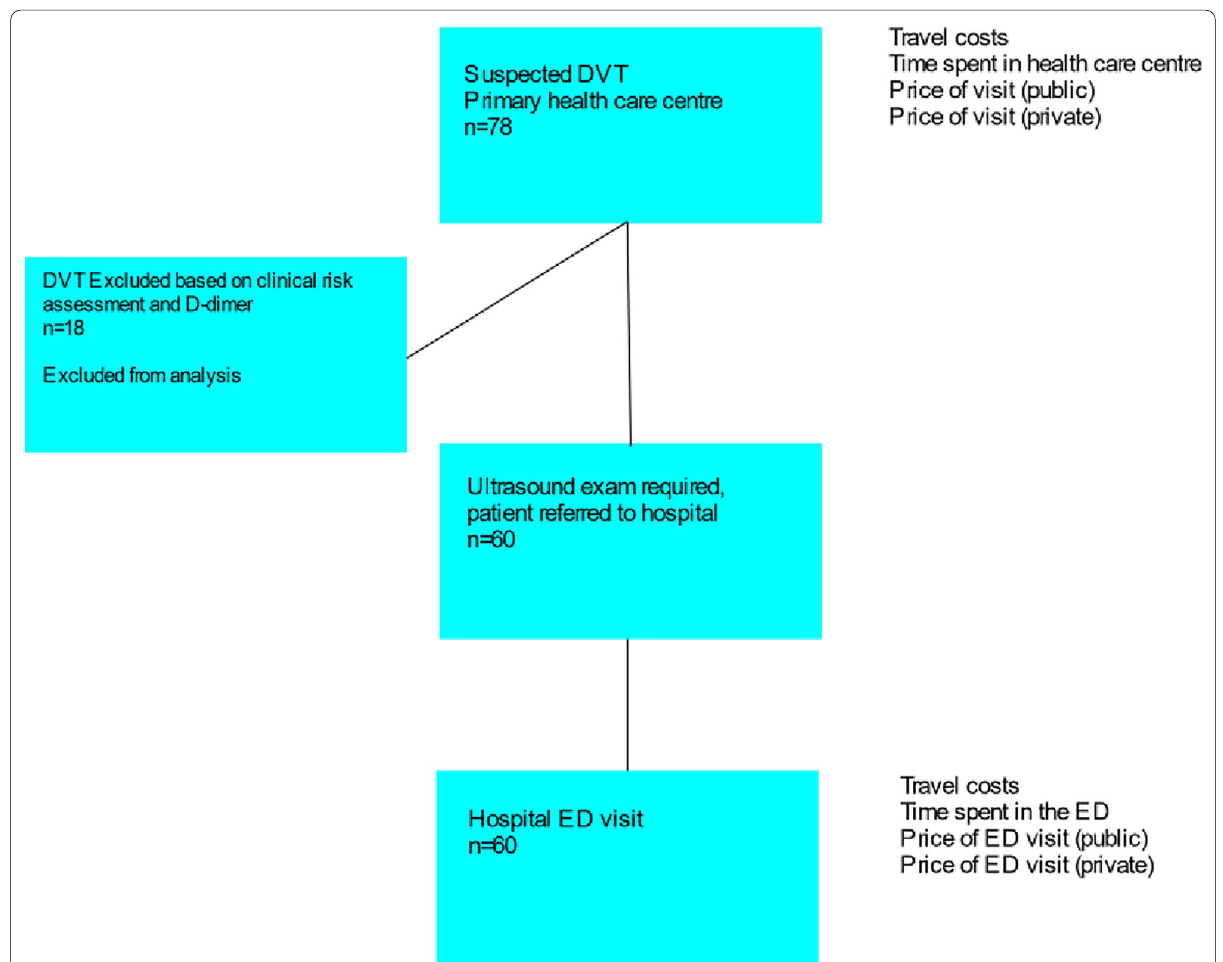
Fig. 1 Standard pathway of DVT diagnostics. The costs associated with different parts of the pathway are